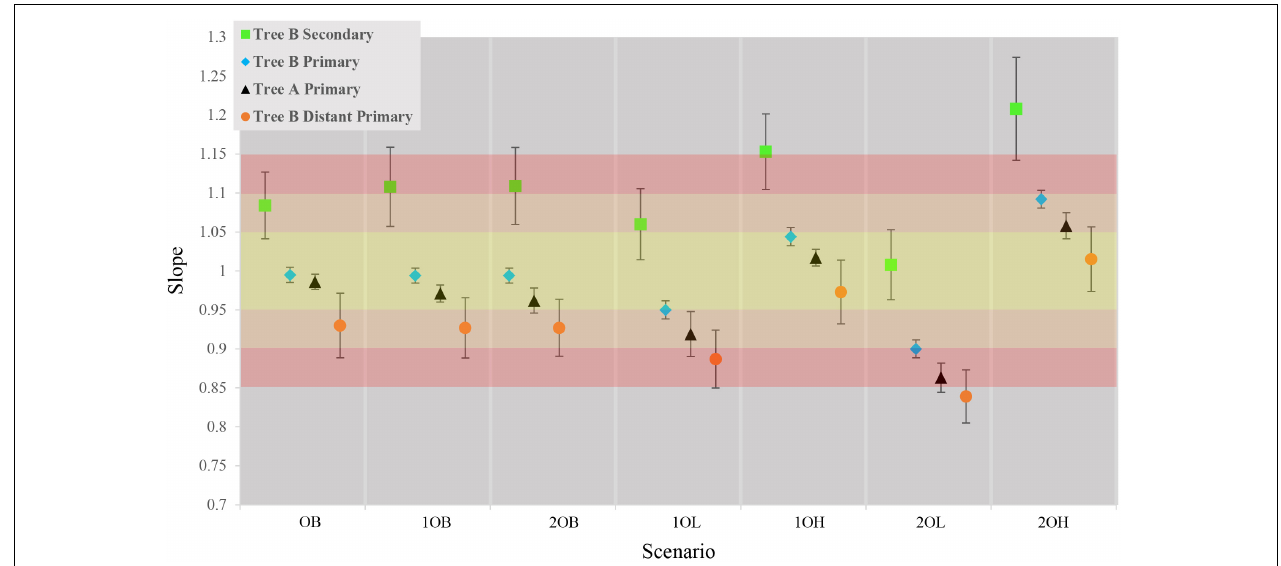
FIGURE 2 | Comparison of average slopes for each of the seven scenarios in the four callibration setting. Gradient of color represents the accuracy of the estimates yellow is ± 5%, Orange ± 10% red = ± 15%. Each data point represents the average slope of the 10 concatensions of true time vs. estimate time with ± 1 standard